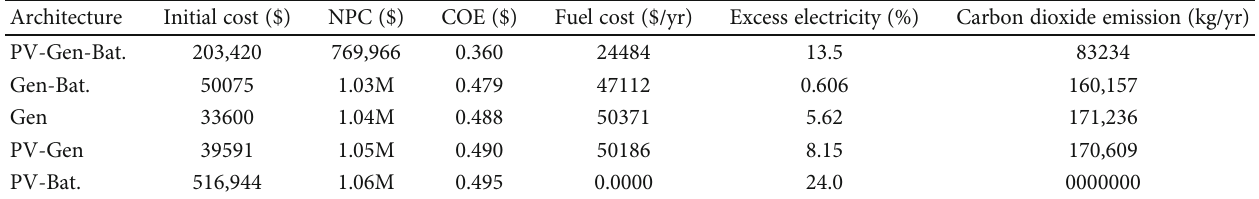
Table 7: Di ff erent architectures of energy sources and their performance for the tertiary scenario.